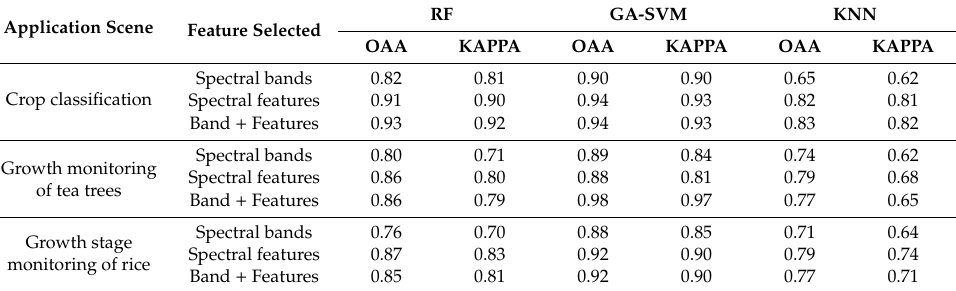
Figure 7. Visualization of rice growth stage monitoring results using a confusion matrix heat map. (( a – c ) are results using RF, ( d – f ) are results using GA-SVM, and ( g – i ) are results using KNN.). Table 6. Classification accuracy of all the spectral library-based application